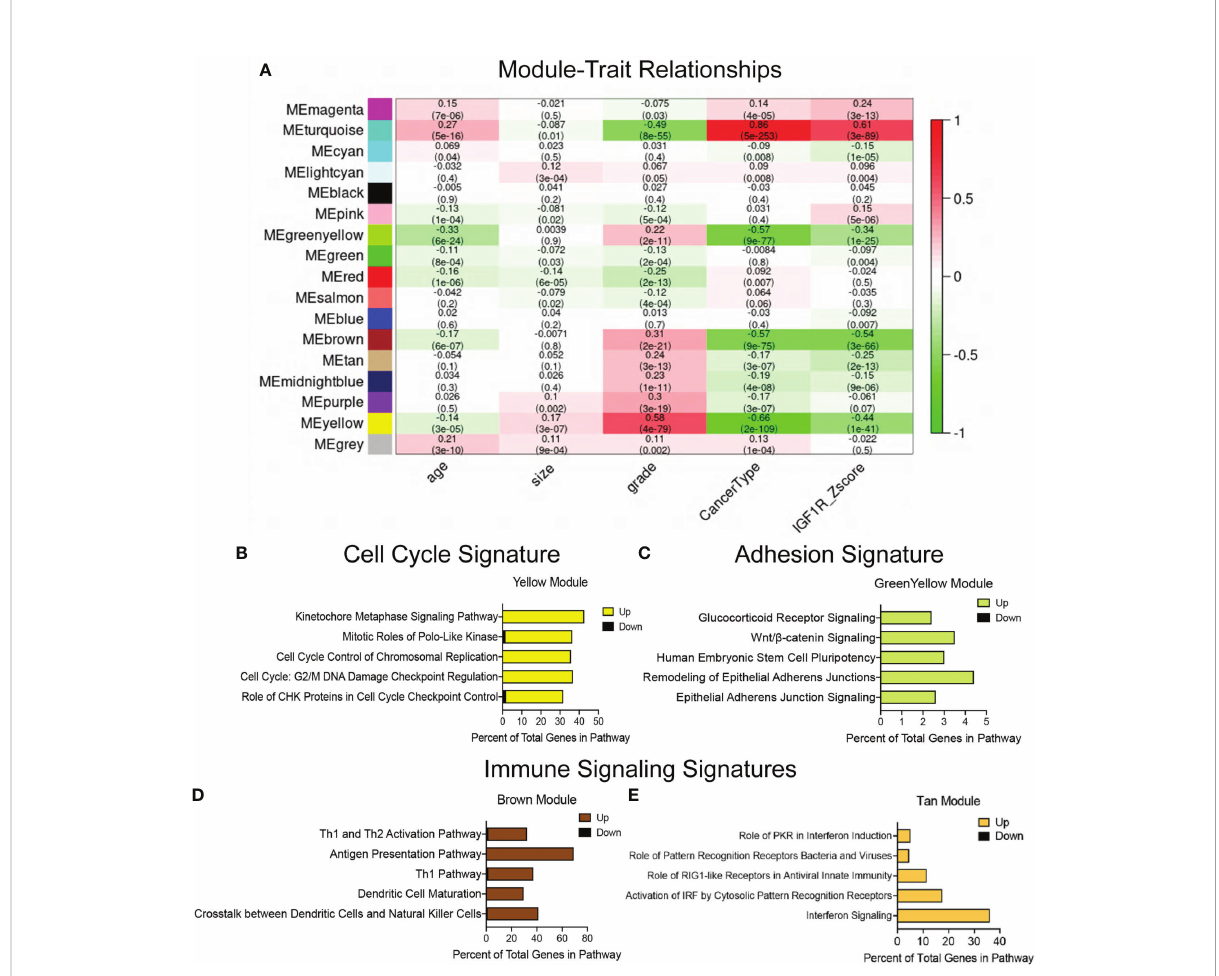
FIGURE 1 De fi ning gene signatures associated with IGF1R expression and tumor phenotype in human breast cancers. (A) Table of re fi ned integrated WGCNA (IGF1R-GS2) showing module and clinical trait association. Each row corresponds to a module eigengene (ME), each column to a clinical measurement. Each cell contains the corresponding correlation and p-value (in parentheses). The table is color-coded by correlation according to the color legend. Green < 0 for negative correlation; Red > 0, for positive correlation. (B – E) Top 5 pathways identi fi ed by ingenuity pathway analysis (IPA) revealing key signatures in 4 modules inversely correlated with IGF1R expression. (yellow module=cell cycle signature, greenyellow module=adhesion signature, brown and tan modules=immune signaling